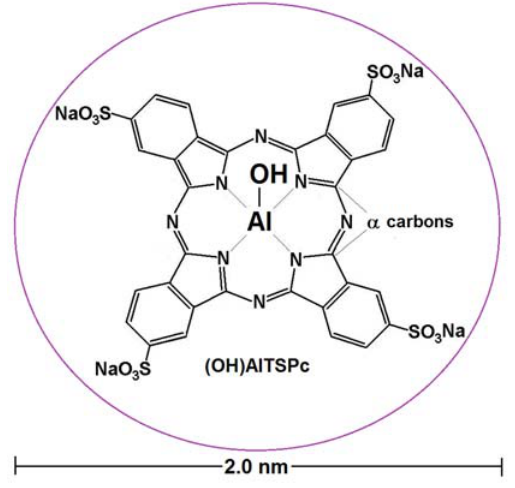
Figure 6. Structure of the μ -hydroxy-tetrasulfophthalocyanine of